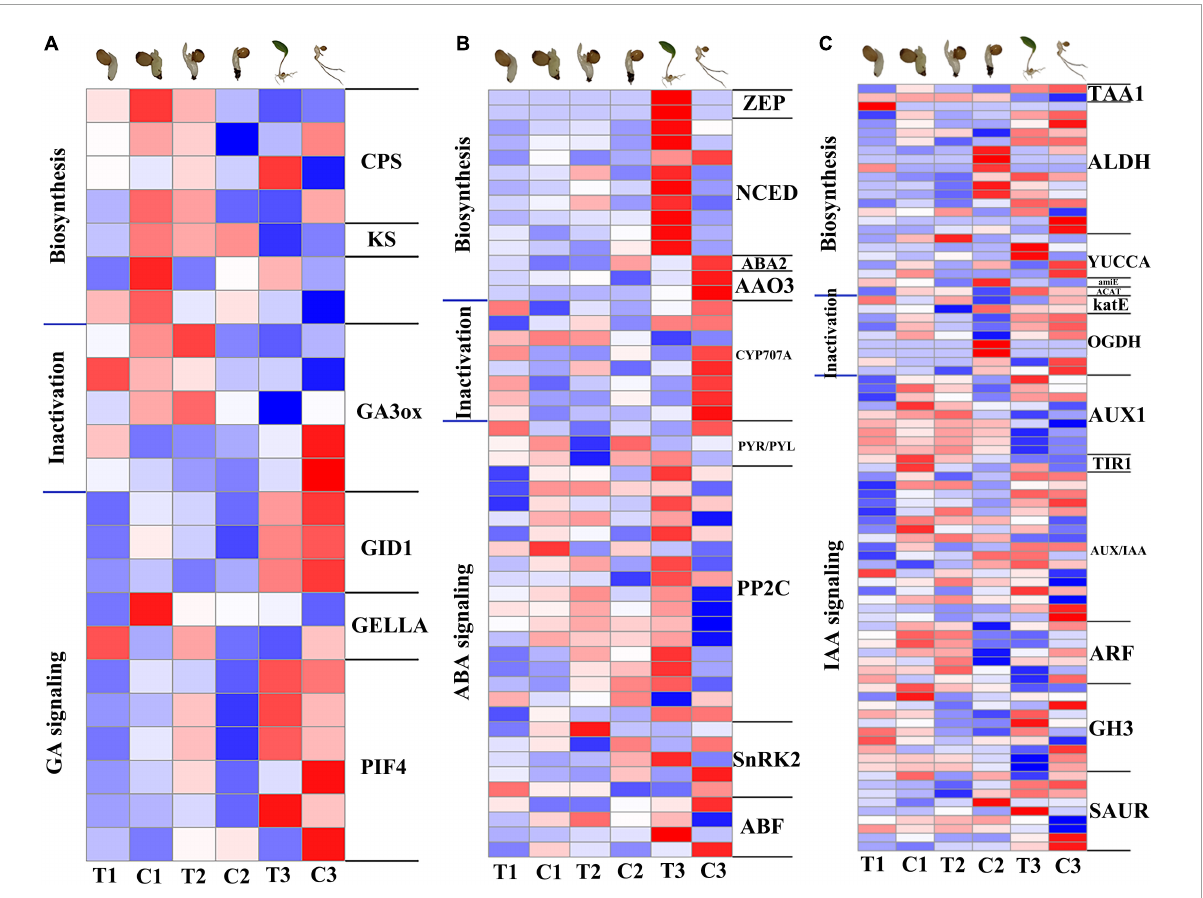
FIGURE5 Expression patterns of genes related to GA, ABA, and IAA biosynthesis, inactivation and signal transduction pathways in transcriptome. (A) Heat map of gene expression related to GA pathway. (B) Heat map of gene expression related to ABA pathway. (C) Heat map of gene expression related to IAA pathway. The color gradient, ranging from blue, through white, to red represents low, middle and high expression of genes. Log 2 (FC) ranges from –1 to